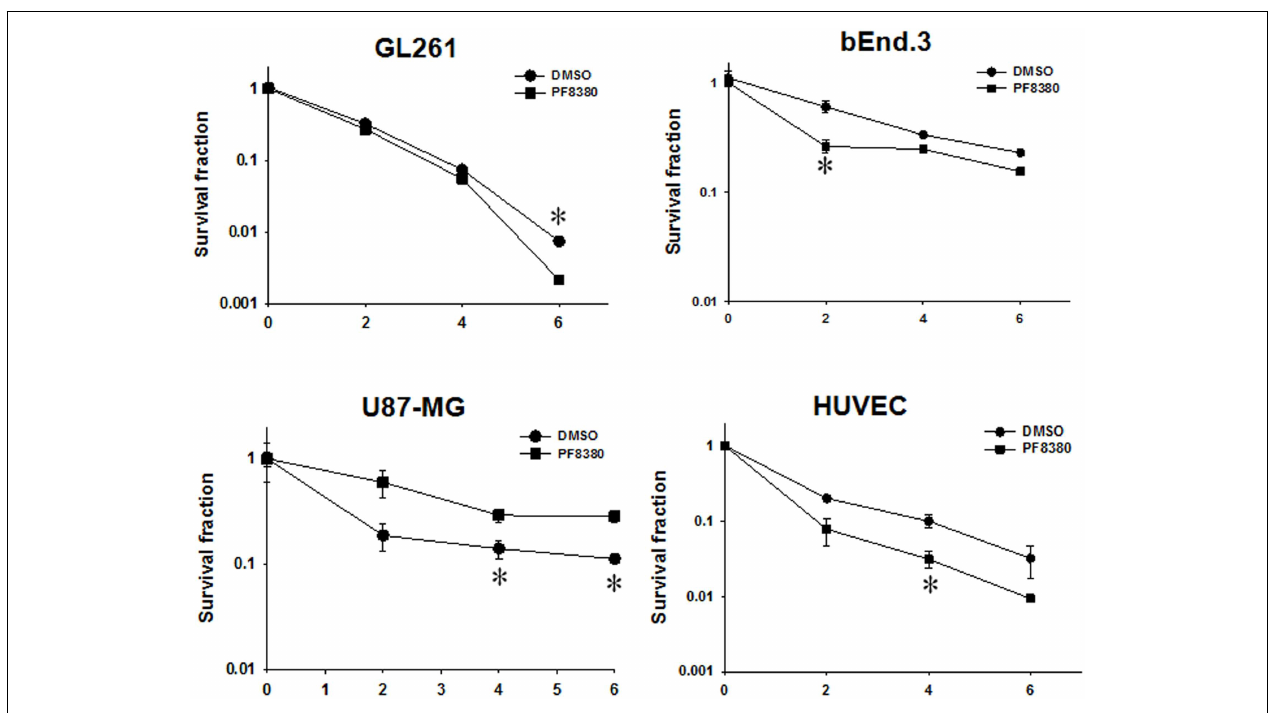
with 1 µ M PF-8380 ( (cid:4) ) or DMSO ( • ) for 45min and irradiated with 0, 2, 4, and 6Gy.The cells were incubated for 7–10days and colonies were fixed, stained with 1% methylene blue, and colonies greater than 50 cells were counted. Shown are the clonogenic survival curve and mean surviving fractions and SEM; * P >